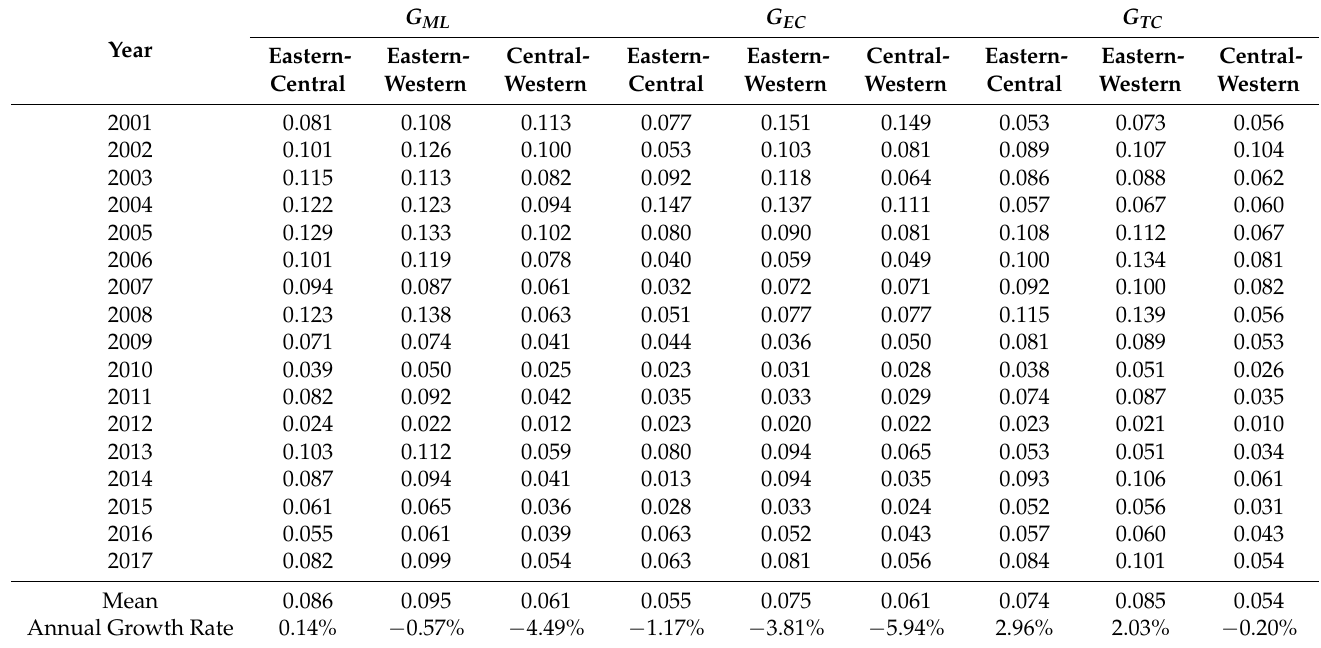
Table 5. Inter-group differences in ML , EC , and TC of